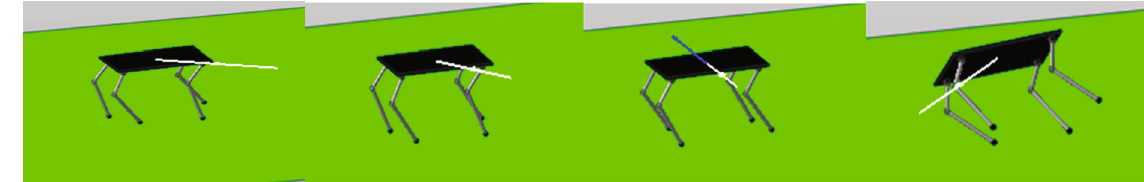
Figure 11: Movement of quadruped robots with full elbow joint under lateral impact.